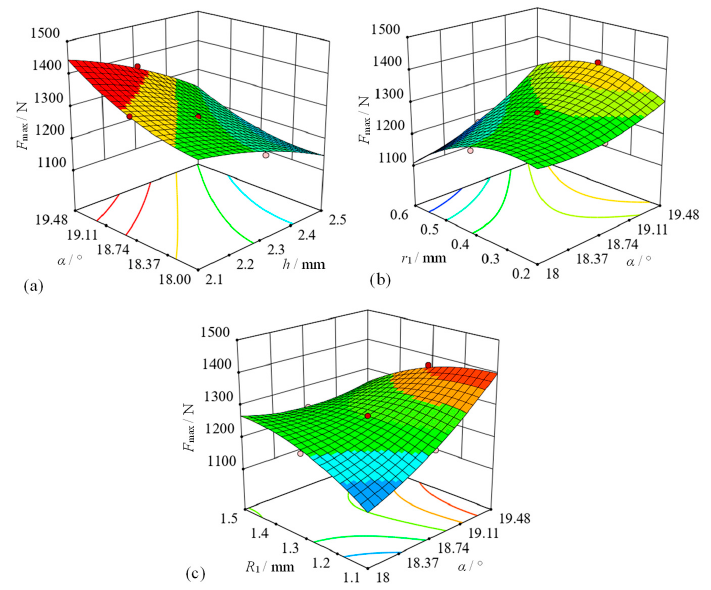
Figure 10. Influence of interaction between ( a ) die depth h and rotated angle α , ( b ) small fillet radius r1 and rotated angle α and ( c ) large fillet radius R1 and rotated angle α on shearing strength illus- trated using 3D surface